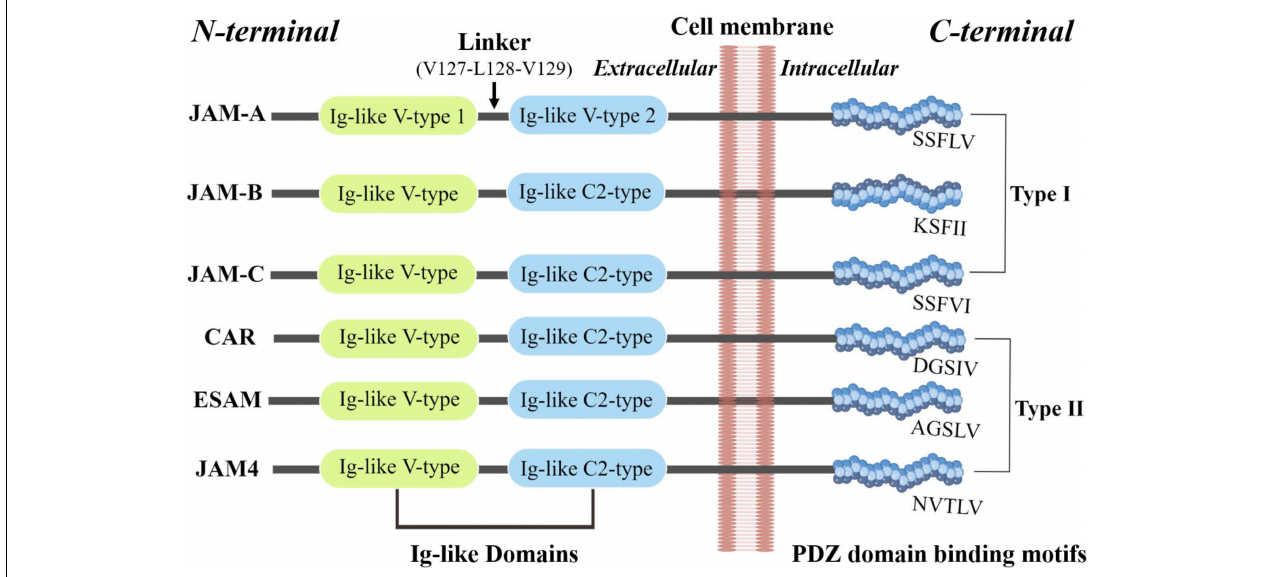
FIGURE 1 | The basic structure of JAMs. JAM family proteins share common structural characteristics: a short N -terminal signal peptide, two extracellular Ig-like domains, a single transmembrane segment, and a short cytoplasmic tail with consensus phosphorylation sites and a C -terminal PDZ-binding motif (173).